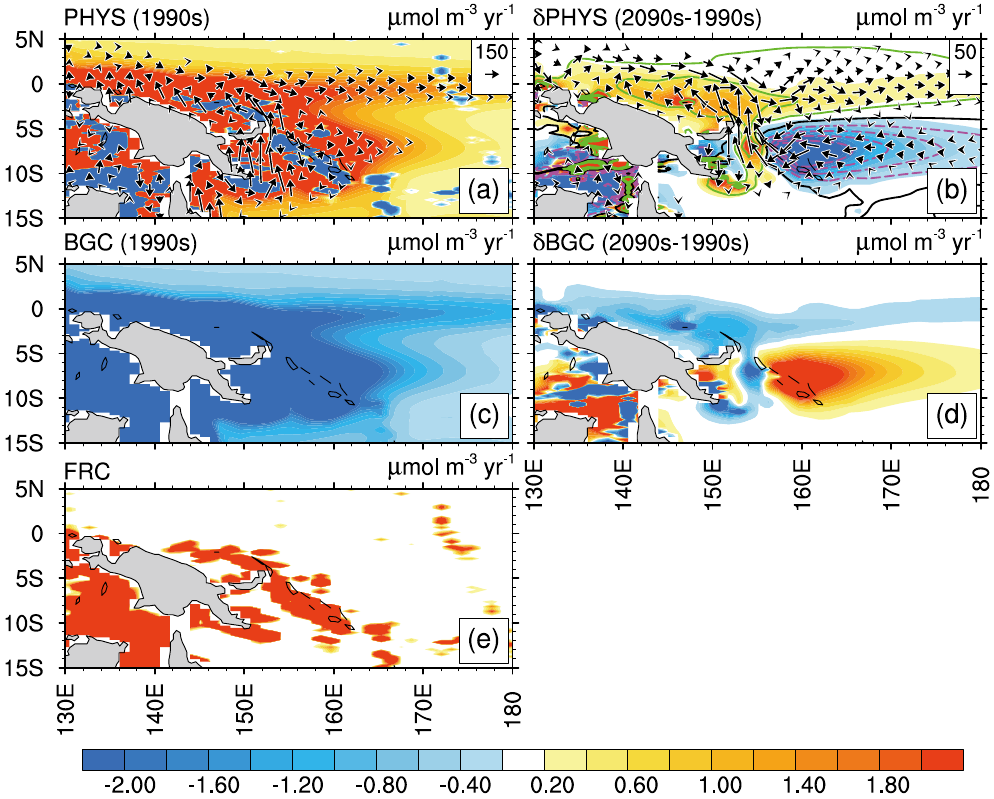
Fig. 9. Spatial distribution of the annual mean dissolved iron tendency (color scale, µmolm − 3 yr − 1 ) averaged over the upper 300m during the 1990s ( a , c and e ) and the difference between the 2090s and 1990s ( b and d ) for the PHYS ( a and b ), BGC ( c and d ), and FRC (e) terms. Vectors represent the horizontal iron flux of PHYS (a) and δ PHYS (b) averaged over the upper 300m (µmolm − 3 yr − 1 ) . The maximum vector length of PHYS ( δ PHYS) is set to 300 (100)µmolm − 3 yr − 1 , and PHYS ( δ PHYS) vectors with magnitudes of less than 30 (10)µmolm − 3 yr − 1 are omitted. Contour lines in (b) are the same as Fig. 8b, except the interval is 0.25nM; contours with absolute values exceeding 1.0nM are